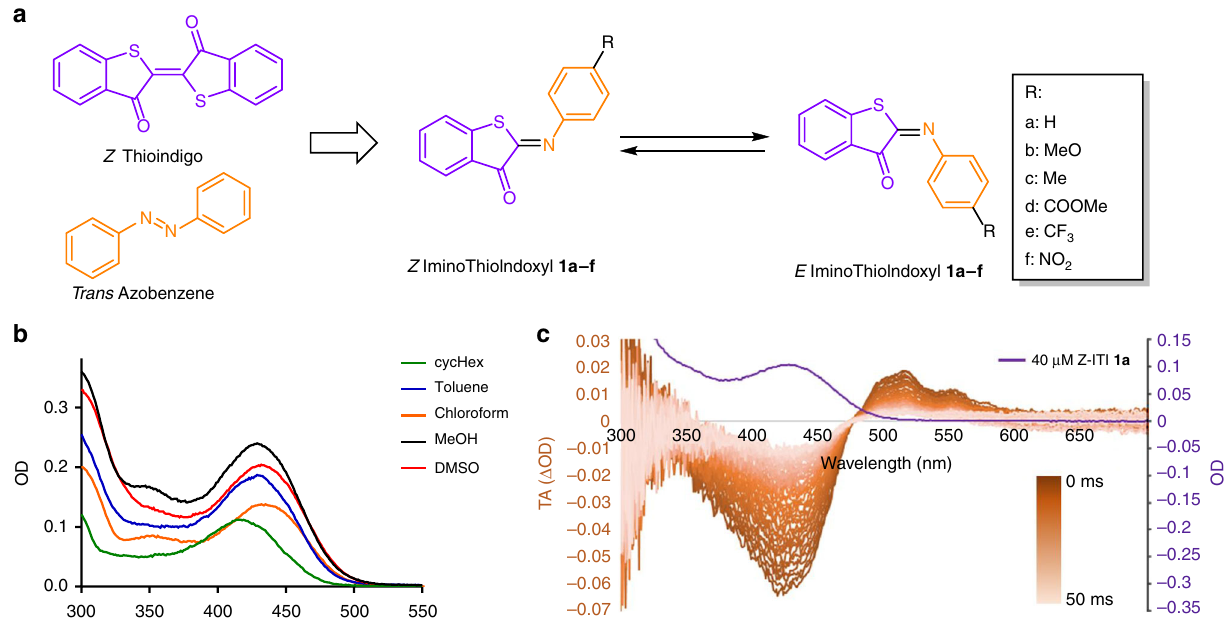
Fig. 1 Design and absorption of ITI. a The structure of Iminothioindoxyl (ITI) is a hybrid of thioindigo (purple) and azobenzene (orange). The R group indicates various substituents to study the electronic effects on the photochemical properties. b Absorption spectra of 40 μ M ITI 1a in cyclohexane, toluene, chloroform, MeOH and DMSO. c Millisecond transient absorption of 400 μ M ITI 1a in MeOH at room temperature. The sample was irradiated with a 430 nm light pulse, upon which the spectrum was recorded with 1 ms delay steps. The color bar represents increased delay of transient absorption spectroscopy and the purple line represents the spectrum of 40 μ M of Z -ITI 1a in MeOH after thermal